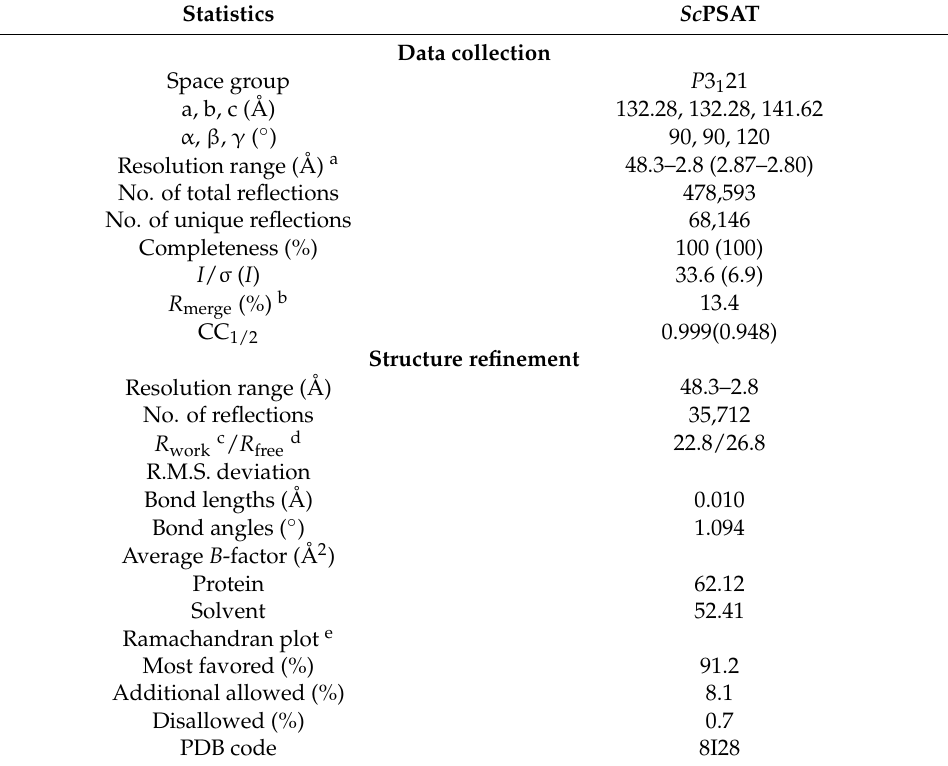
Table 2. Data collection and refinement statistics for Sc